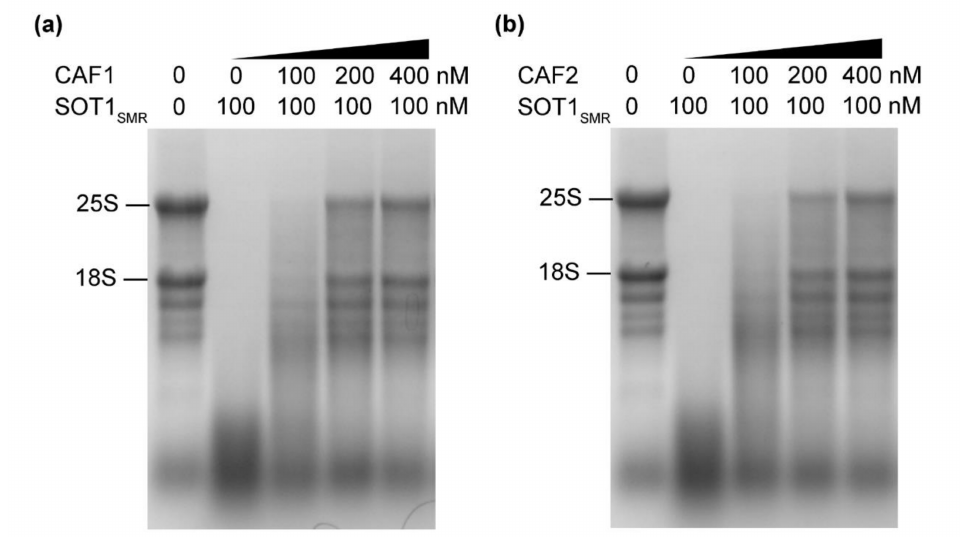
Figure 7. The RNA nuclease activity of the SMR domain of SOT1 can be inhibited by CAF proteins. The recombinant SOT1 SMR protein, together with increasing concentrations of CAF1 ( a ) or CAF2 ( b ) proteins, was incubated with total wild-type Arabidopsis RNA at 25 ◦ C for 30 min. The reaction products were separated on agarose/formaldehyde gels and observed using ethidium bromide staining. Three independent experiments were performed, and one representative experiment is